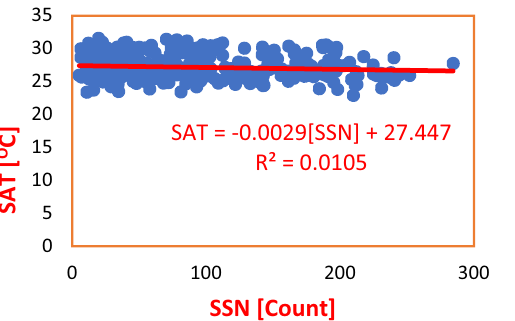
Figure 2. Regression of SSN on SAT in PHC during Solar Cycles 22–24. SSN made a 1% influence on SAT. The Regression Equation shows that a unit increase in SSN by 1 Count resulted to an insignificant decease in SAT by an average of 0.0029 O C.